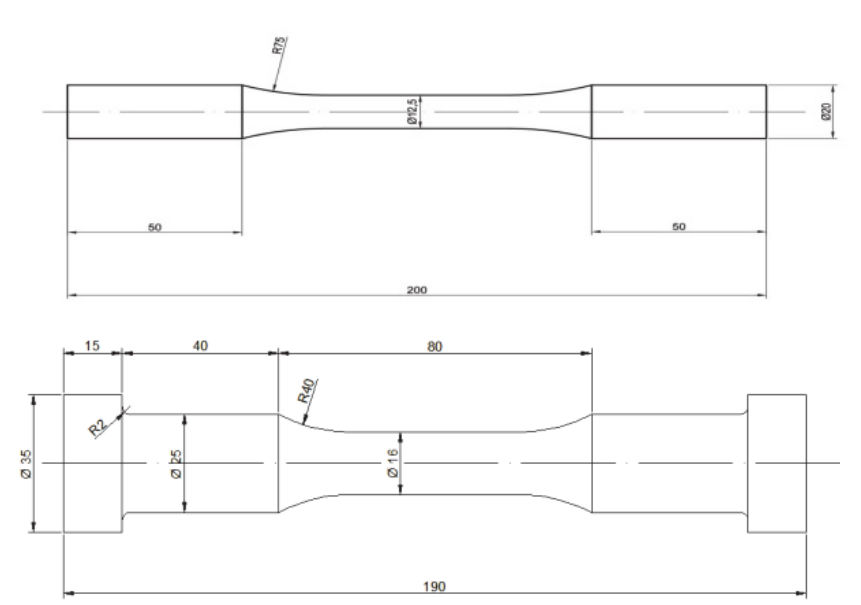
Figure 1: Geometry of the experimental specimens.